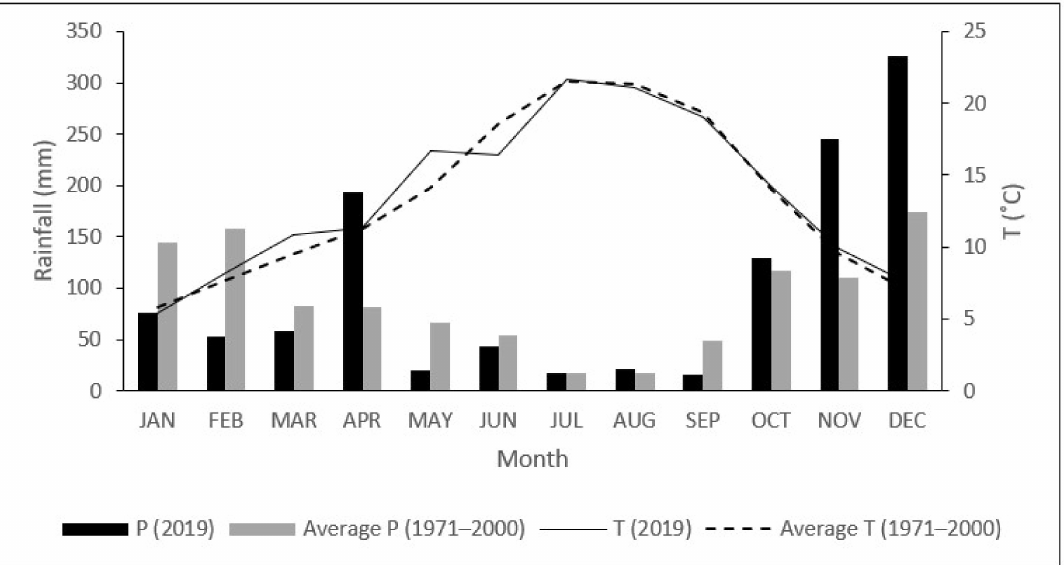
Figure 1. Average monthly Temperature (T, ◦ C) and rainfall (P, mm) in 2019 and